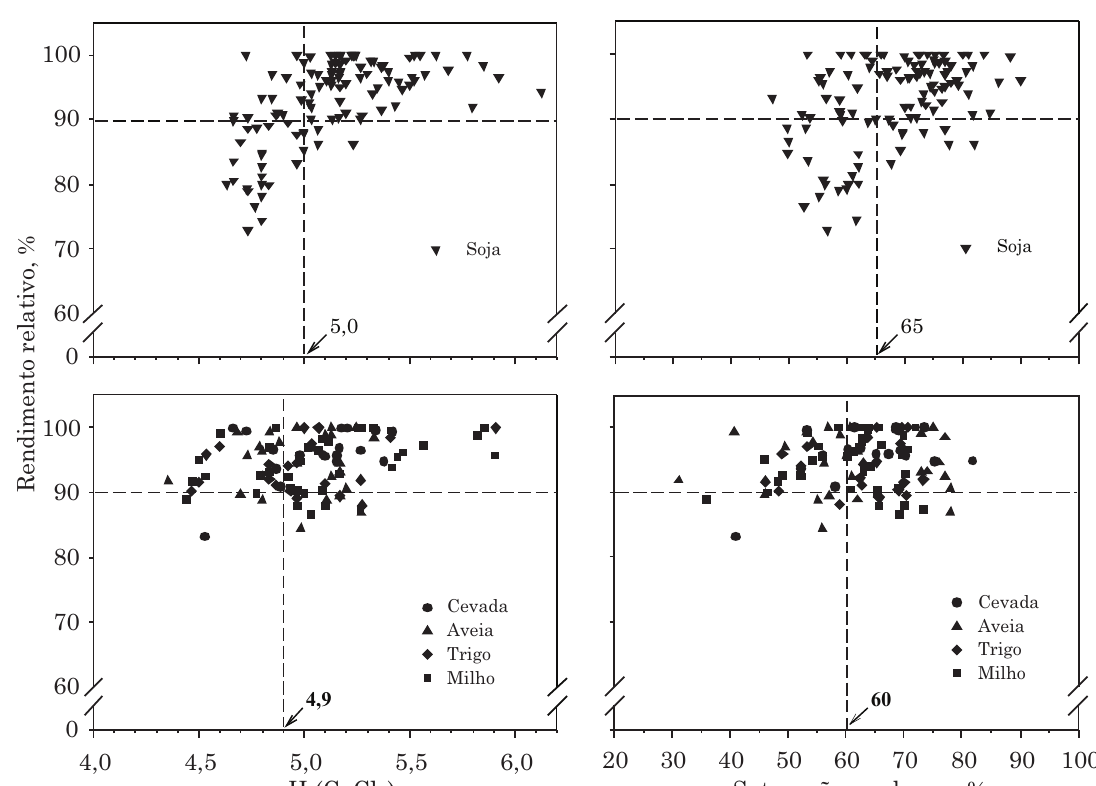
Figura 2. Relação entre o rendimento relativo de grãos e os indicadores de acidez, pH (CaCl 2 ) e saturação por bases, na camada de 0-0,10 m de solos, em plantio direto na